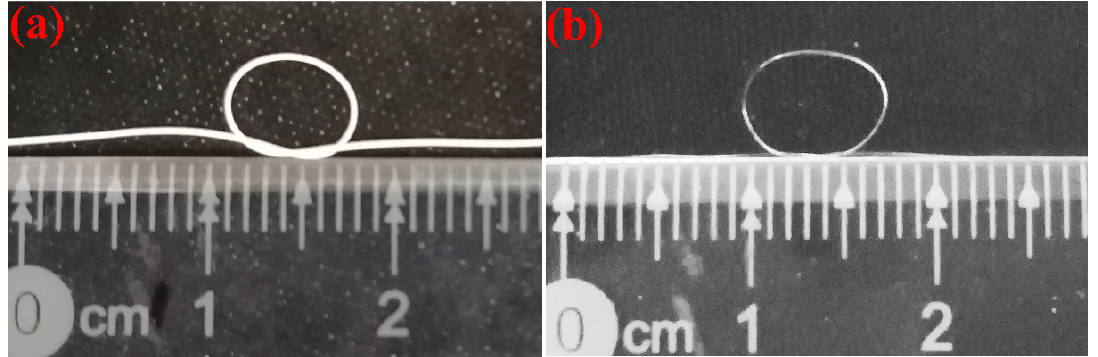
Figure 7. Sample of YAG ceramic fiber by melt spinning: ( a ) flexible green body of ceramic fiber with the mass ratio of TPU ‐ 95A# to ceramic powder = 4:6, ( b ) TPU ‐ 95A# melt spinning.